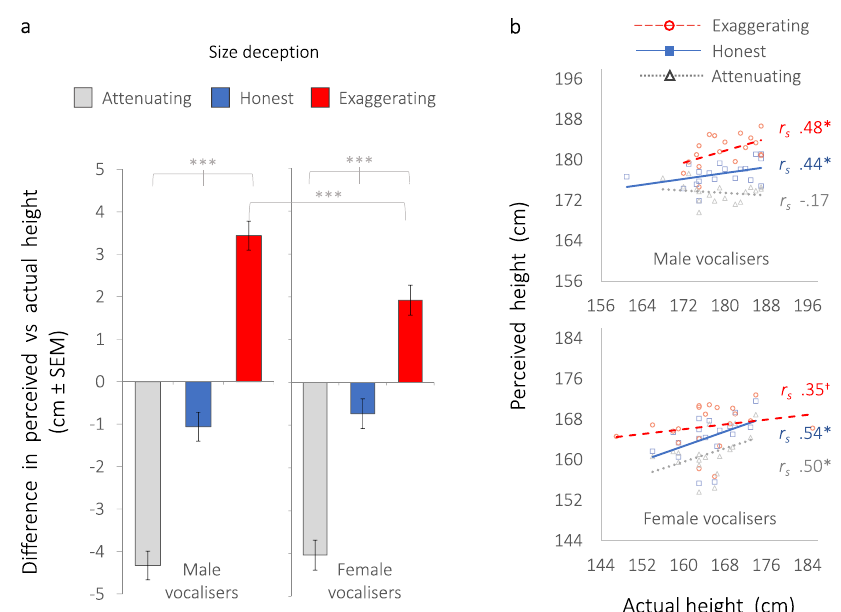
Fig. 2 Vocal size deception biases judgements of body size (Experiment 1). a Bias in height judgements shown as the mean difference (±SEM) between perceived and actual heights of vocalisers, in cm, for honest vocal signals (central blue bars) and deceptive vocal signals (attenuating size = grey bars, exaggerating size = red bars), where 0 indicates accurate height judgements, positive values indicate overestimation, and negative values indicate underestimation. Estimated marginal means and pairwise comparisons derive from linear mixed models, LMMs (see Supplementary Table 5), where all *** p < 0.001 following Š idák correction for multiple comparisons. Tests are two-tailed. Error bars represent standard errors of the mean, ±SEM. See also Supplementary Fig. 1 for dot plots illustrating the distribution of data. b Linear regressions showing relationships between perceived and actual heights of vocalisers, where each dot represents a vocaliser, and height judgements are averaged across listeners for each vocaliser and each size condition (exaggerating size = red circles, honest = blue squares, attenuating = grey triangles), where Cook ’ s Di < 0.20 (see Methods). 1 cm on the x -axis is equal to 1 cm on the y -axis. Spearman ’ s rho ( r s ) correlation coef fi cients are given for each regression line, where * p < 0.05, one-tailed (males exaggerating r = 0.48, p = 0.02, n = 18; honest r = 0.44, p = 0.03, n = 19; attenuating r = − 0.17, p = 0.25, n = 18; females exaggerating r = 0.35, p = 0.06, n = 20; honest r = 0.54, p = 0.01; n = 18; attenuating r = 0.50, p = 0.02; n = 18). All data were de r ived from Experiment 1 based on 120 vocal stimuli produced by n = 40 vocalisers (20 males, 20 females) in each of three size conditions (honest, attenuating, exaggerating) and judged by n = 97 listeners, where each vocal stimulus was rated by an average of 50 listeners (see Methods). Source data are provided as a Source Data fi